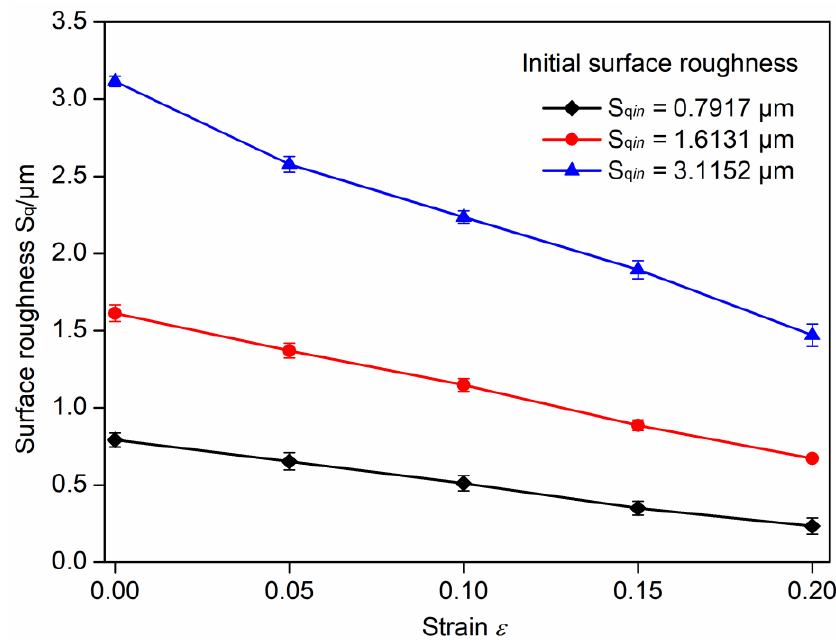
Figure 7. Variation of surface roughness for different values of the initial surface